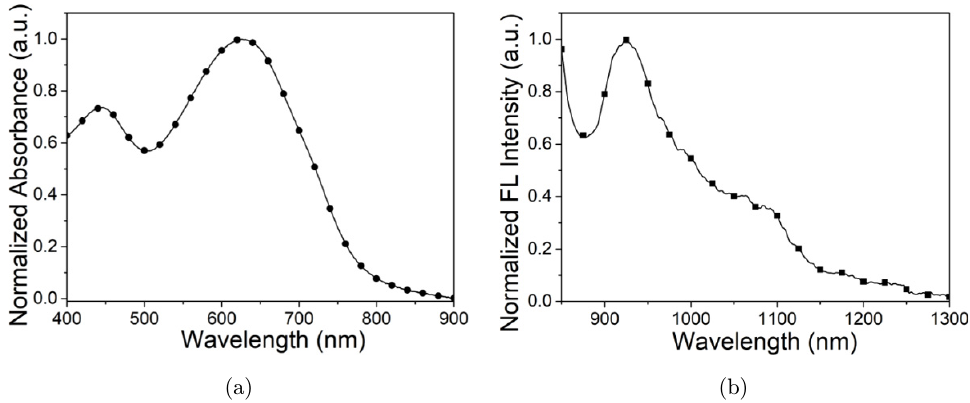
Fig. 4. Normalized absorption spectrum (a) and normalized °uorescence spectrum (b) of PDTSDTBT nanoparticles in